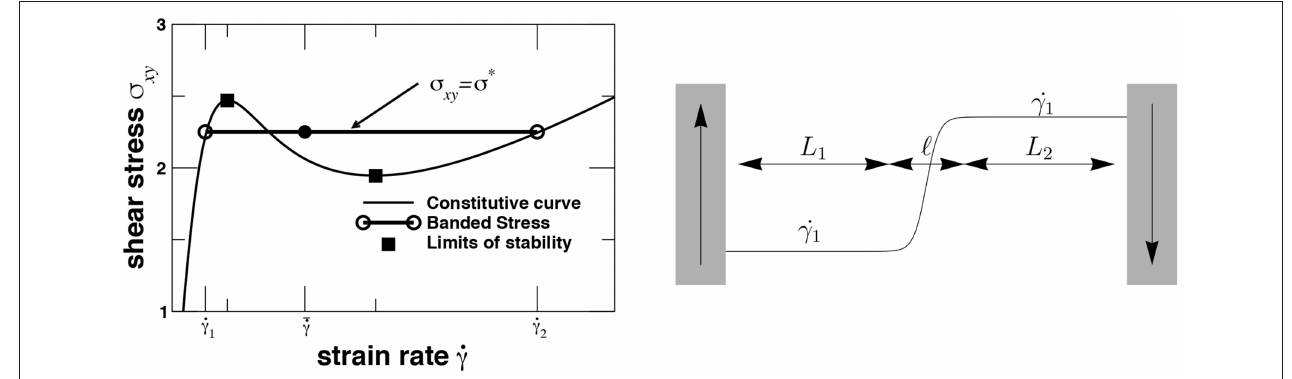
γ 1 < ¯˙ γ < γ 2 shear rates γ 1 and γ 2 coexist ˙ ˙ ˙ ˙